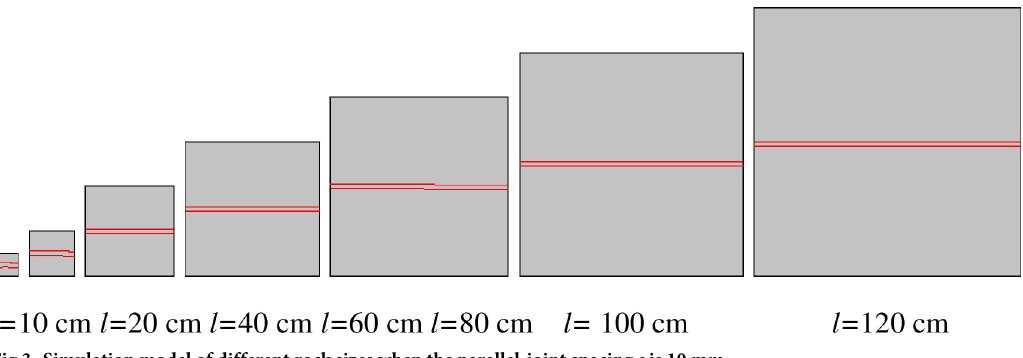
Fig 3. Simulation model of different rock sizes when the parallel-joint spacing s is 10